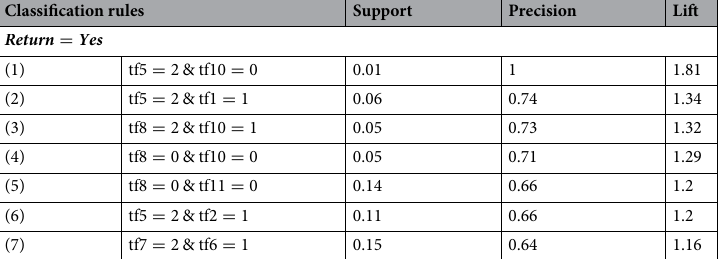
Table 4. Classification rules for Return = Yes on MiniTF with the following parameter settings: support lower boundary = 0.01 , maximum rule length = 2 , maximum number of child rules = 800 , minimum gain in precision = 0.01 , p-value < 0.05 (without correction for multiple testing). The categorical items are encoded with 2 = True , 1 = Partially True, and 0 =